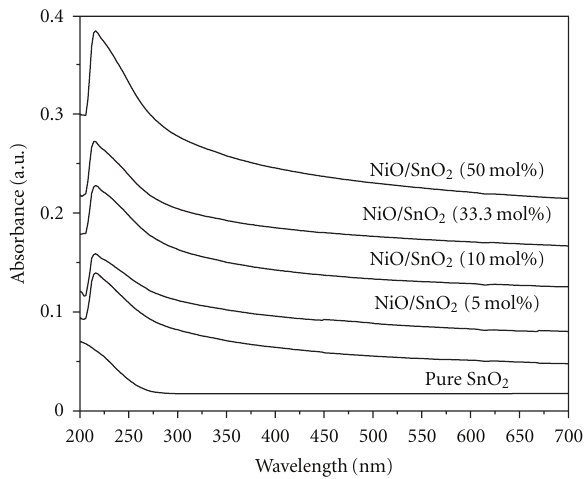
Figure 5: UV-V is absorption spectrum of pure and nickel-doped SnO 2